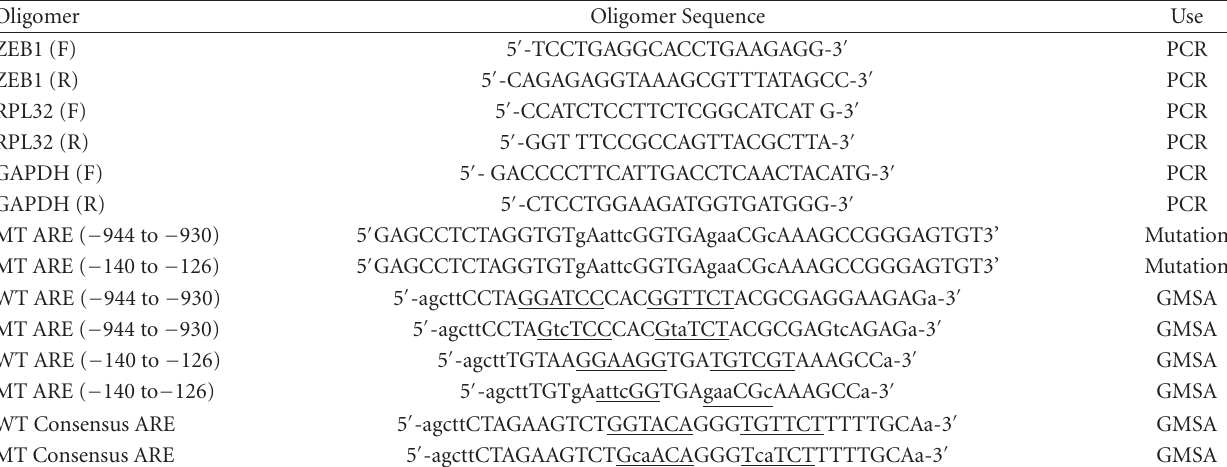
Table 1: The oligomer sequences used for qPCR, mutagenesis, and GMSA.